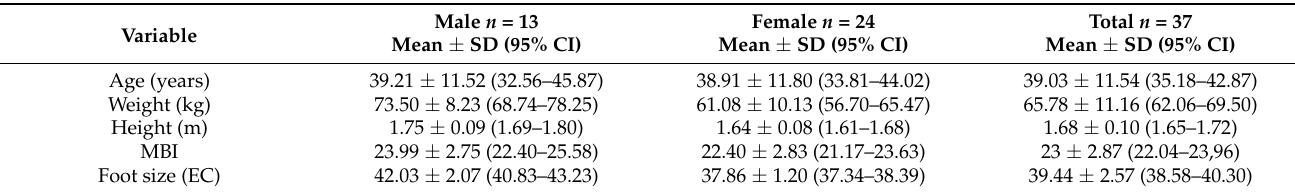
Table 2. Descriptive data of the study participants showing demographics and anthropometric characteristics for the total sample by gender.